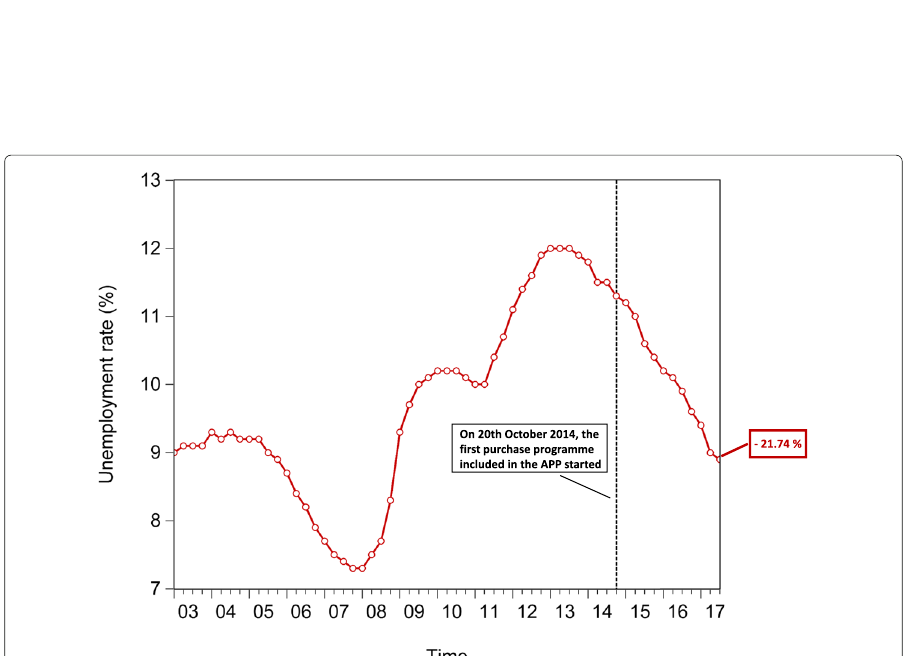
Fig. 17 Euro area unemployment rate; 2003Q1-2017Q2. Time series of the Harmonised Unemployment Rate (HUR), over the reference period 2003Q1-2017Q2. The vertical line corresponds to the beginning of the first purchase programme (3rd Covered Bond Purchase Programme, CBPP3) included in the APP, started in 2014Q4, while the percentage on the right-hand side of the graph corresponds to our estimate of the growth rate of euro area HUR, since the initiation of QE. Data source: (Eurostat